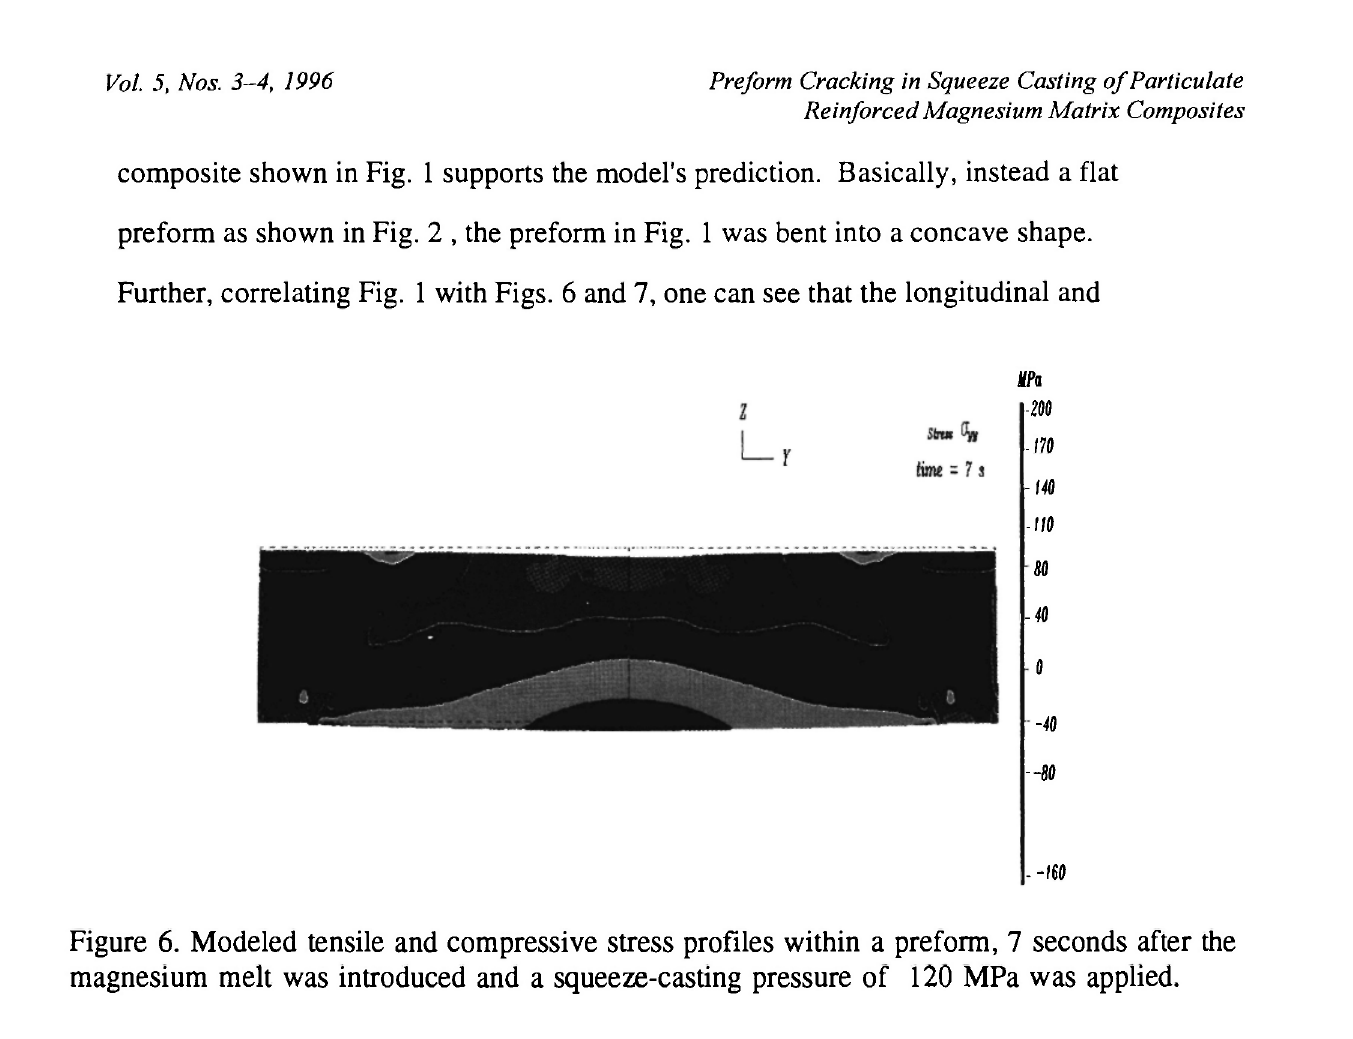
Figure 6. Modeled tensile and compressive stress profiles within a preform, 7 seconds after the magnesium melt was introduced and a squeeze-casting pressure of 120 MPa was applied.